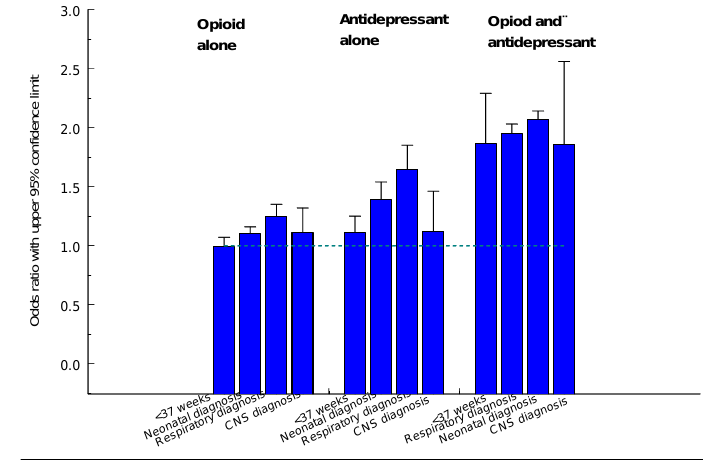
Figure 8. Diagrams showing odds ratios for four neonatal outcomes after maternal use of opioids or antidepressants alone and after use of a combination of the drugs.